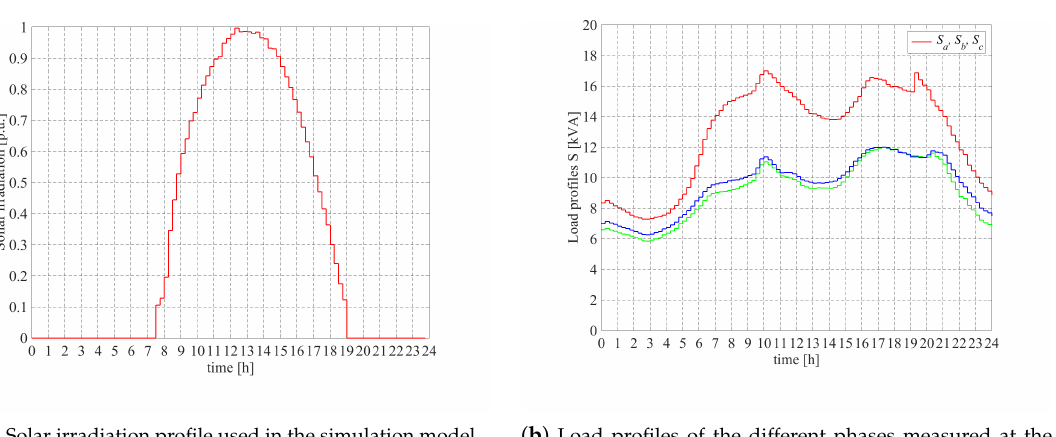
Figure 4. Solar irradiation and load profiles used in the simulation